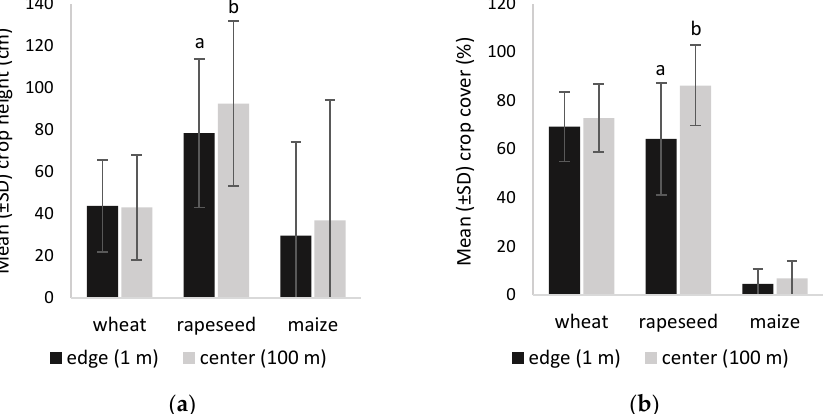
Figure 3. Comparison of ( a ) mean crop height and ( b ) mean crop cover in each crop type at different distances from the edge of the field. Vertical lines represent the standard deviation (SD). Superscripts indicate significant differences between the edge and center for each crop type, based on Tukey’s post-hoc tests.